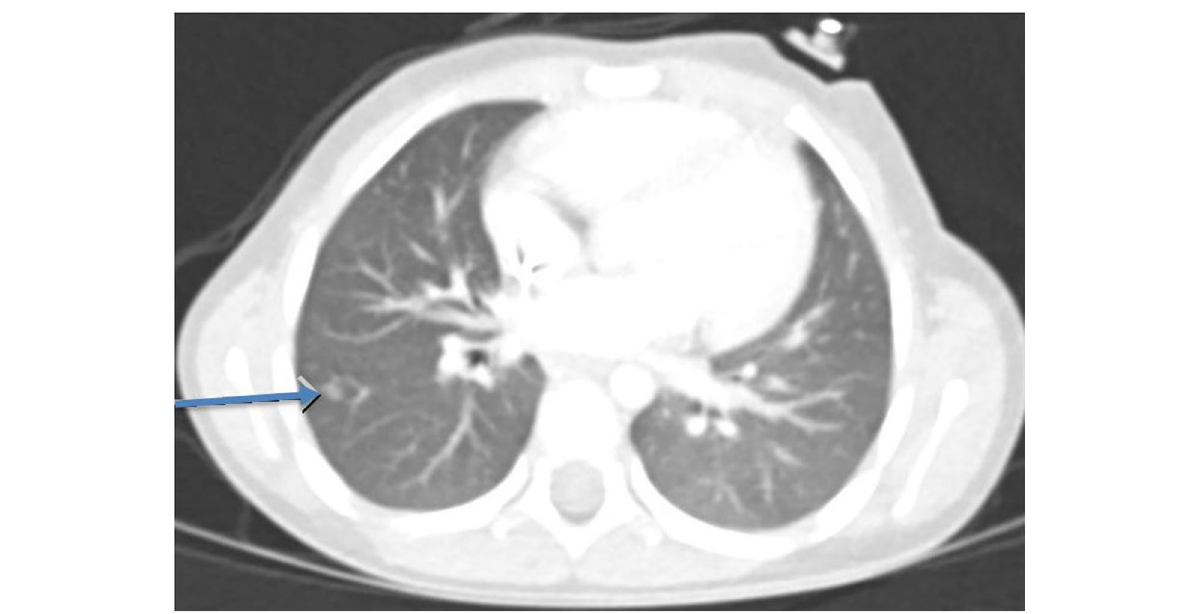
Fig. 1 Transverse chest CT image of a 4-year-old girl (15 kg, CTDIvol 1.4 mGy). There is a subcentimeter nodule in the right lower lobe (arrow). Median IQSC score was